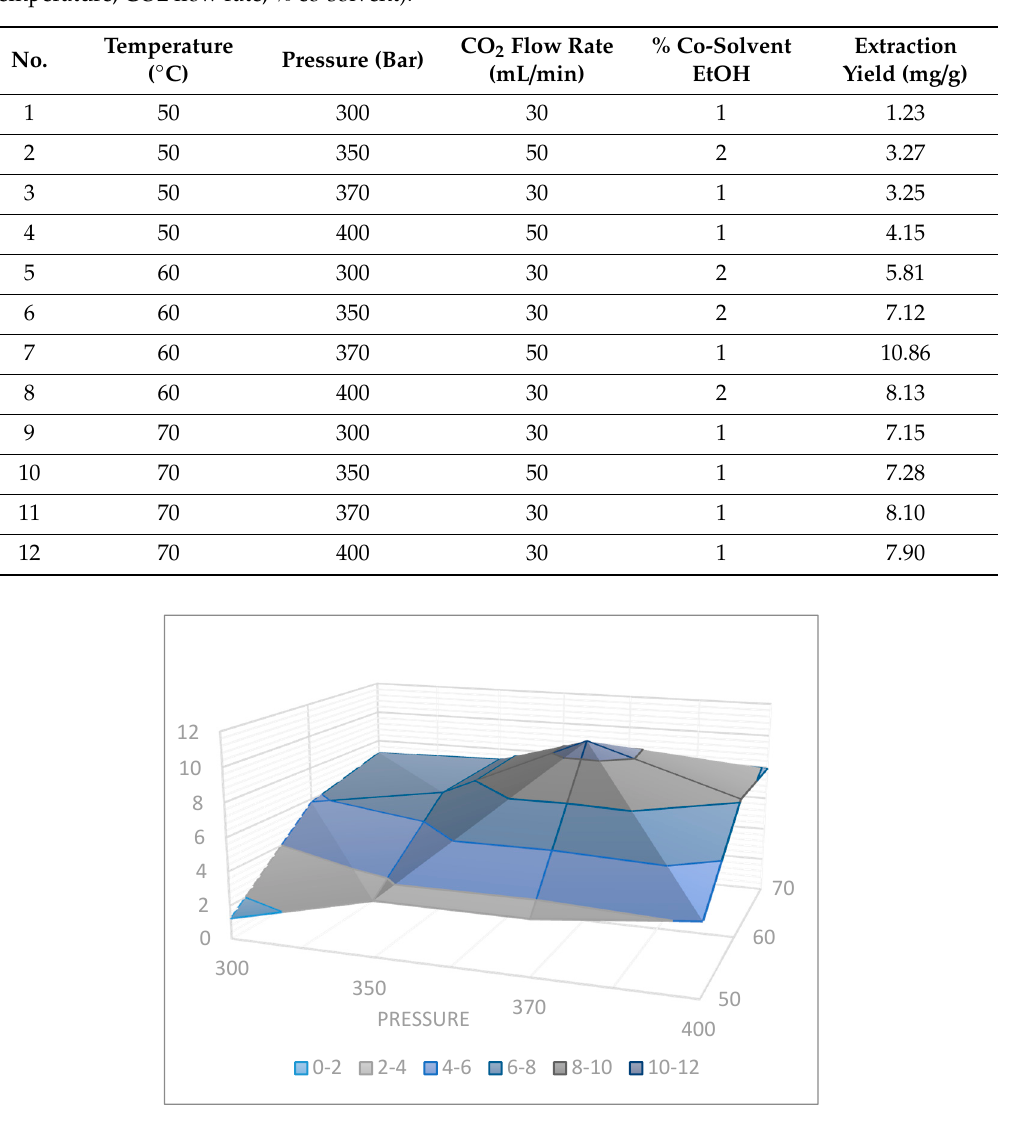
Figure 1. Orthogonal projection representing the extraction yield of target analytes at 300 to 400 Bar and 50–70 °C.